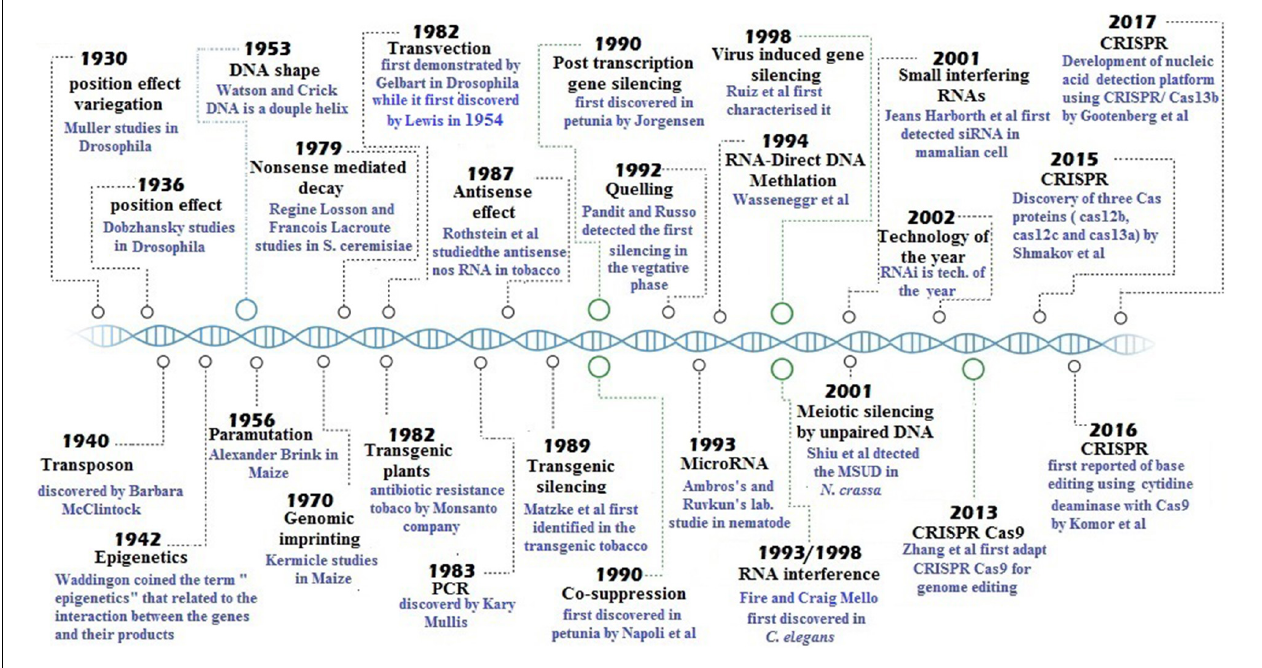
FIGURE 1 | History of gene